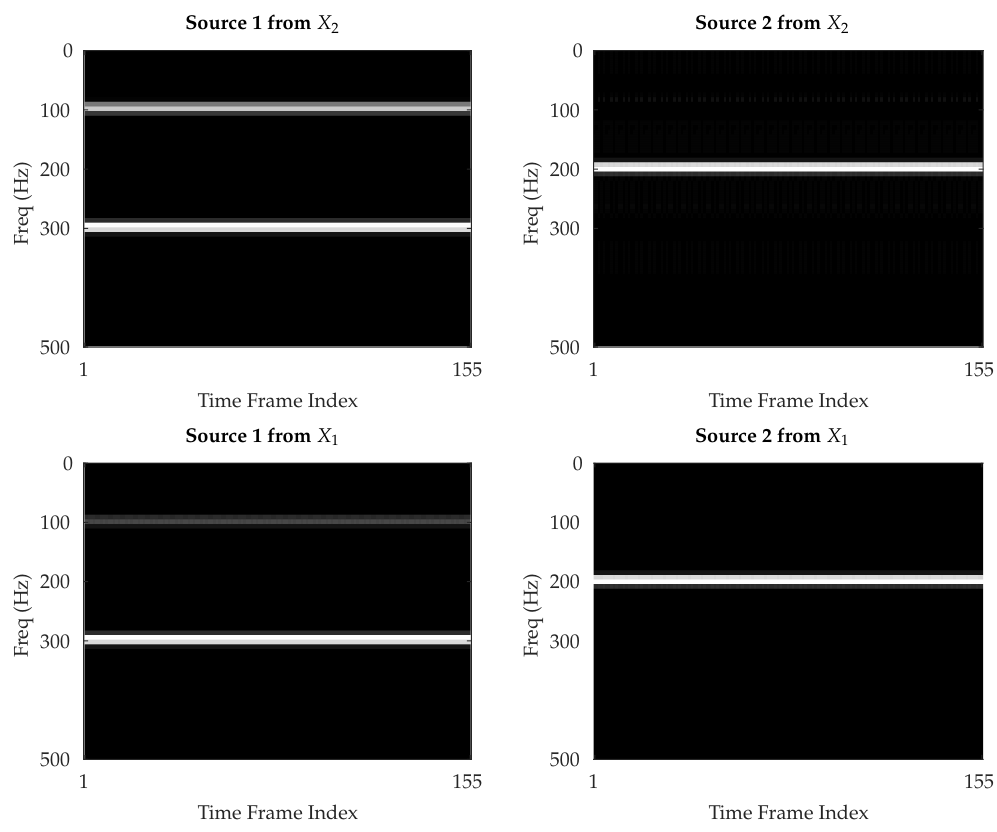
Figure 4. The reconstruction achieved by Adress using an azimuth subspace width of H = 65 azimuths is illustrated. We use 100 azimuths for the LHS component and 100 azimuths for the RHS component of the azimugram. In the case that H = 65, only one de-mixed spectra contains the 300 Hz frequency component. The value H = 65 is chosen so that the peak at the frequency f 3 is assigned to the nearest source. The peak at 0.96 is approximately 61 azimuths away from the peak − at 0.35 and so it is assigned to the source s 1 . The peak at 0.4 is 75 azimuths away from the peak − at 0.35 and so the f 2 frequency component is not assigned to the s 1 source. Choosing a smaller H − might result in the f 3 component not being assigned to either source. Choosing H can be a